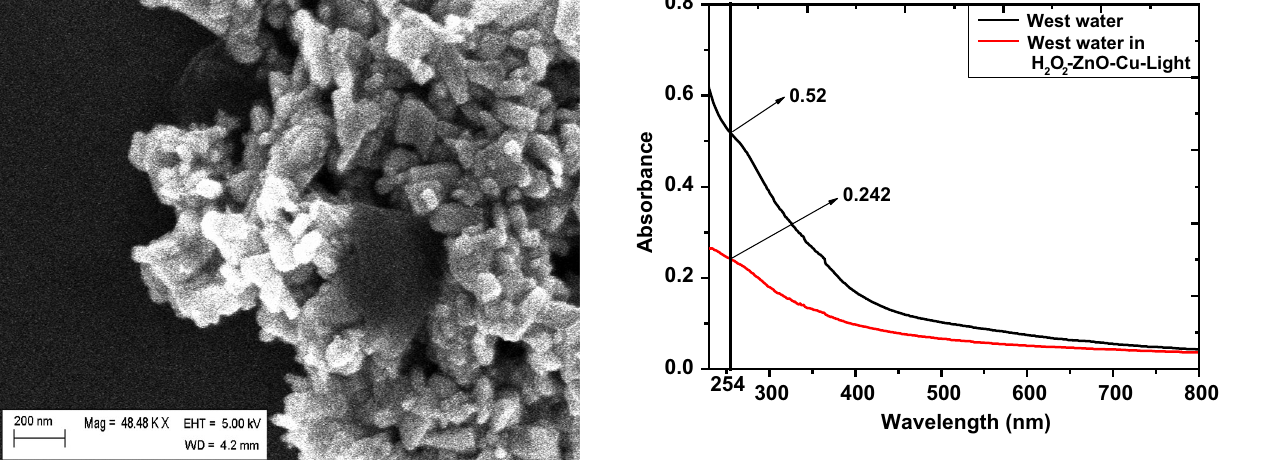
Fig. 4 SEM image of ZnO–CuO composite particles